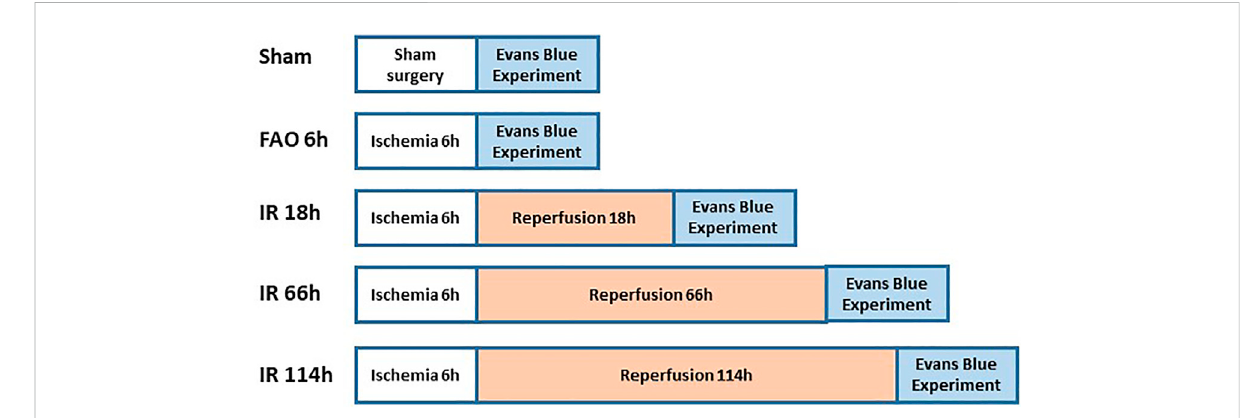
Animal grouping and study protocols in Evans blue experiment.